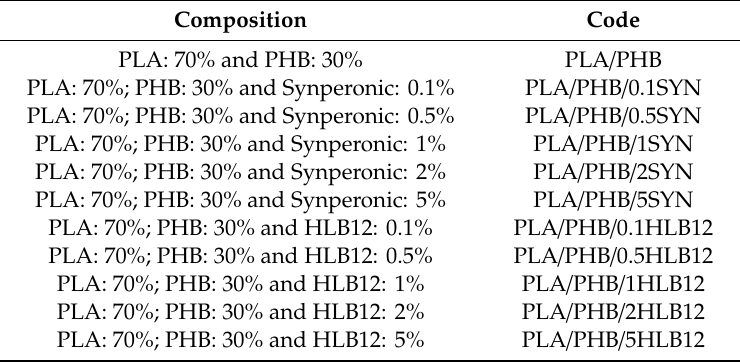
Table 1. Composition and code of the studied blends (all percentages are referred to as wt.%). Composition Code PLA: 70% and PHB: